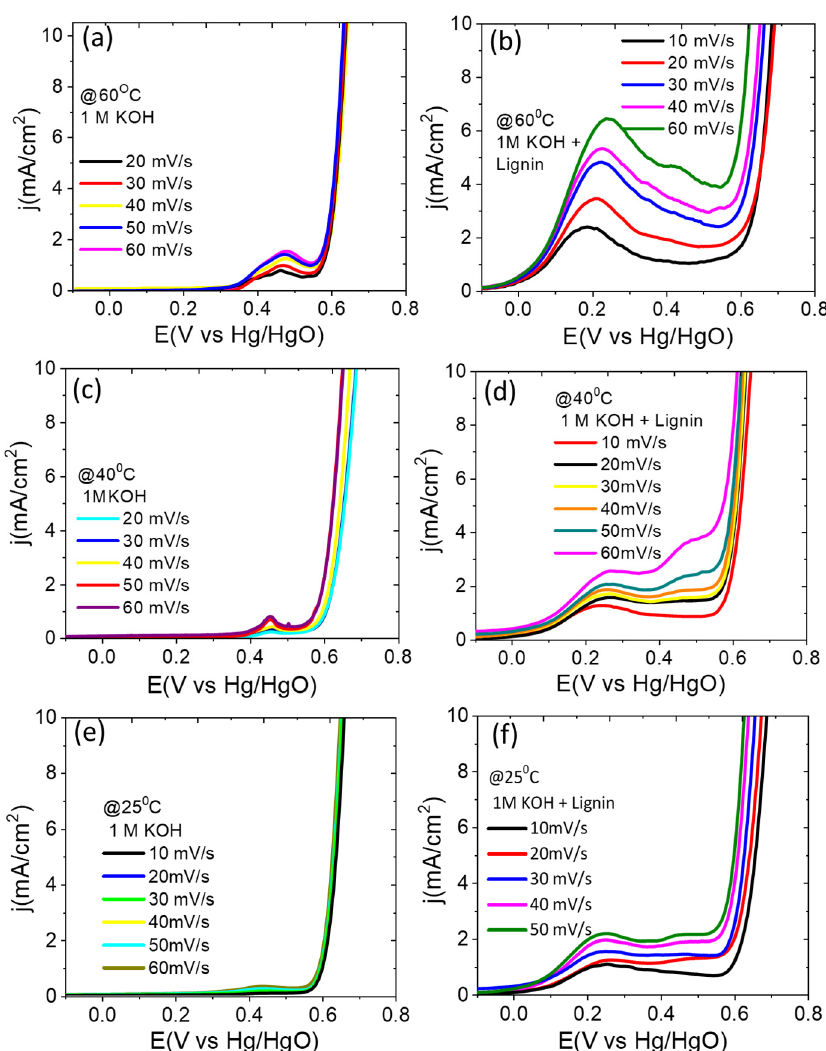
Figure 5. LSV curves for the P-NiFeCo/NC at different temperatures in ( a , c , e ) 1 M KOH and ( b , d , f ) in e.c.l. electrolyte.